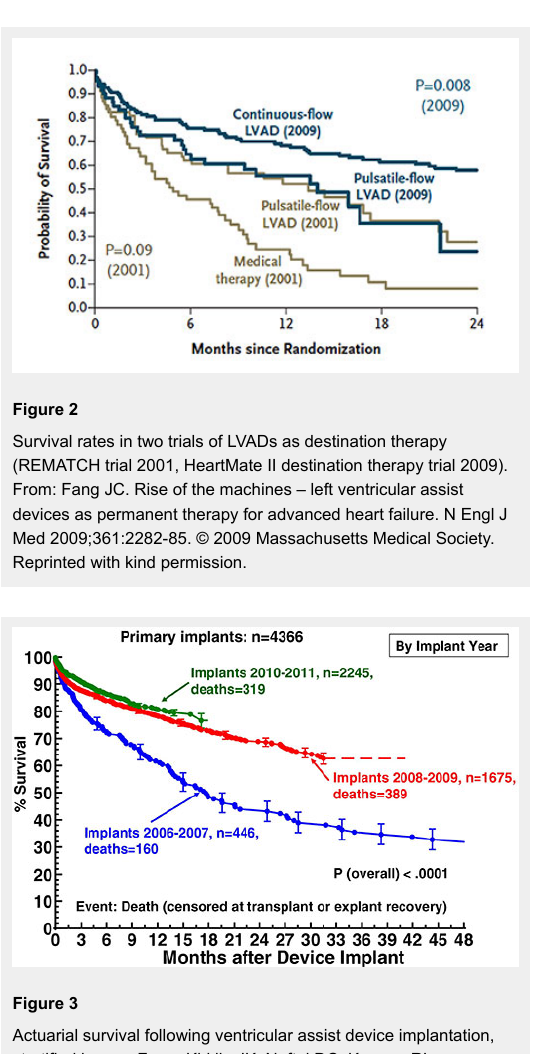
Actuarial survival following ventricular assist device implantation, stratified by era. From: Kirklin JK, Naftel DC, Kormos RL, Stevenson LW, Pagani FD, et al. The Fourth INTERMACS Annual Report: 4,000 implants and counting. J Heart Lung Transplant 2012;31:117–26. © 2012 Elsevier. Reprinted with kind